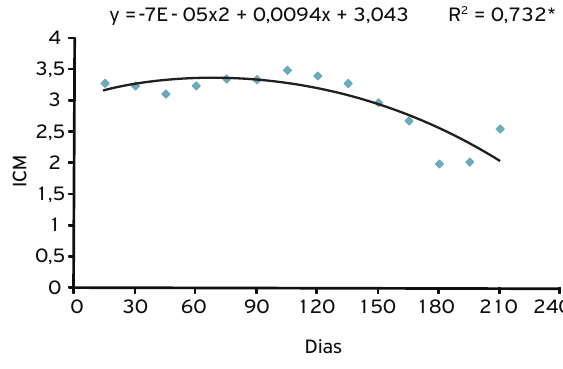
*significância 5%; ICM: índice de crescimento Figura 3. Crescimento micelial de P. solitum imobilizado em alginato de sódio e armazenado em diferentes temperaturas.